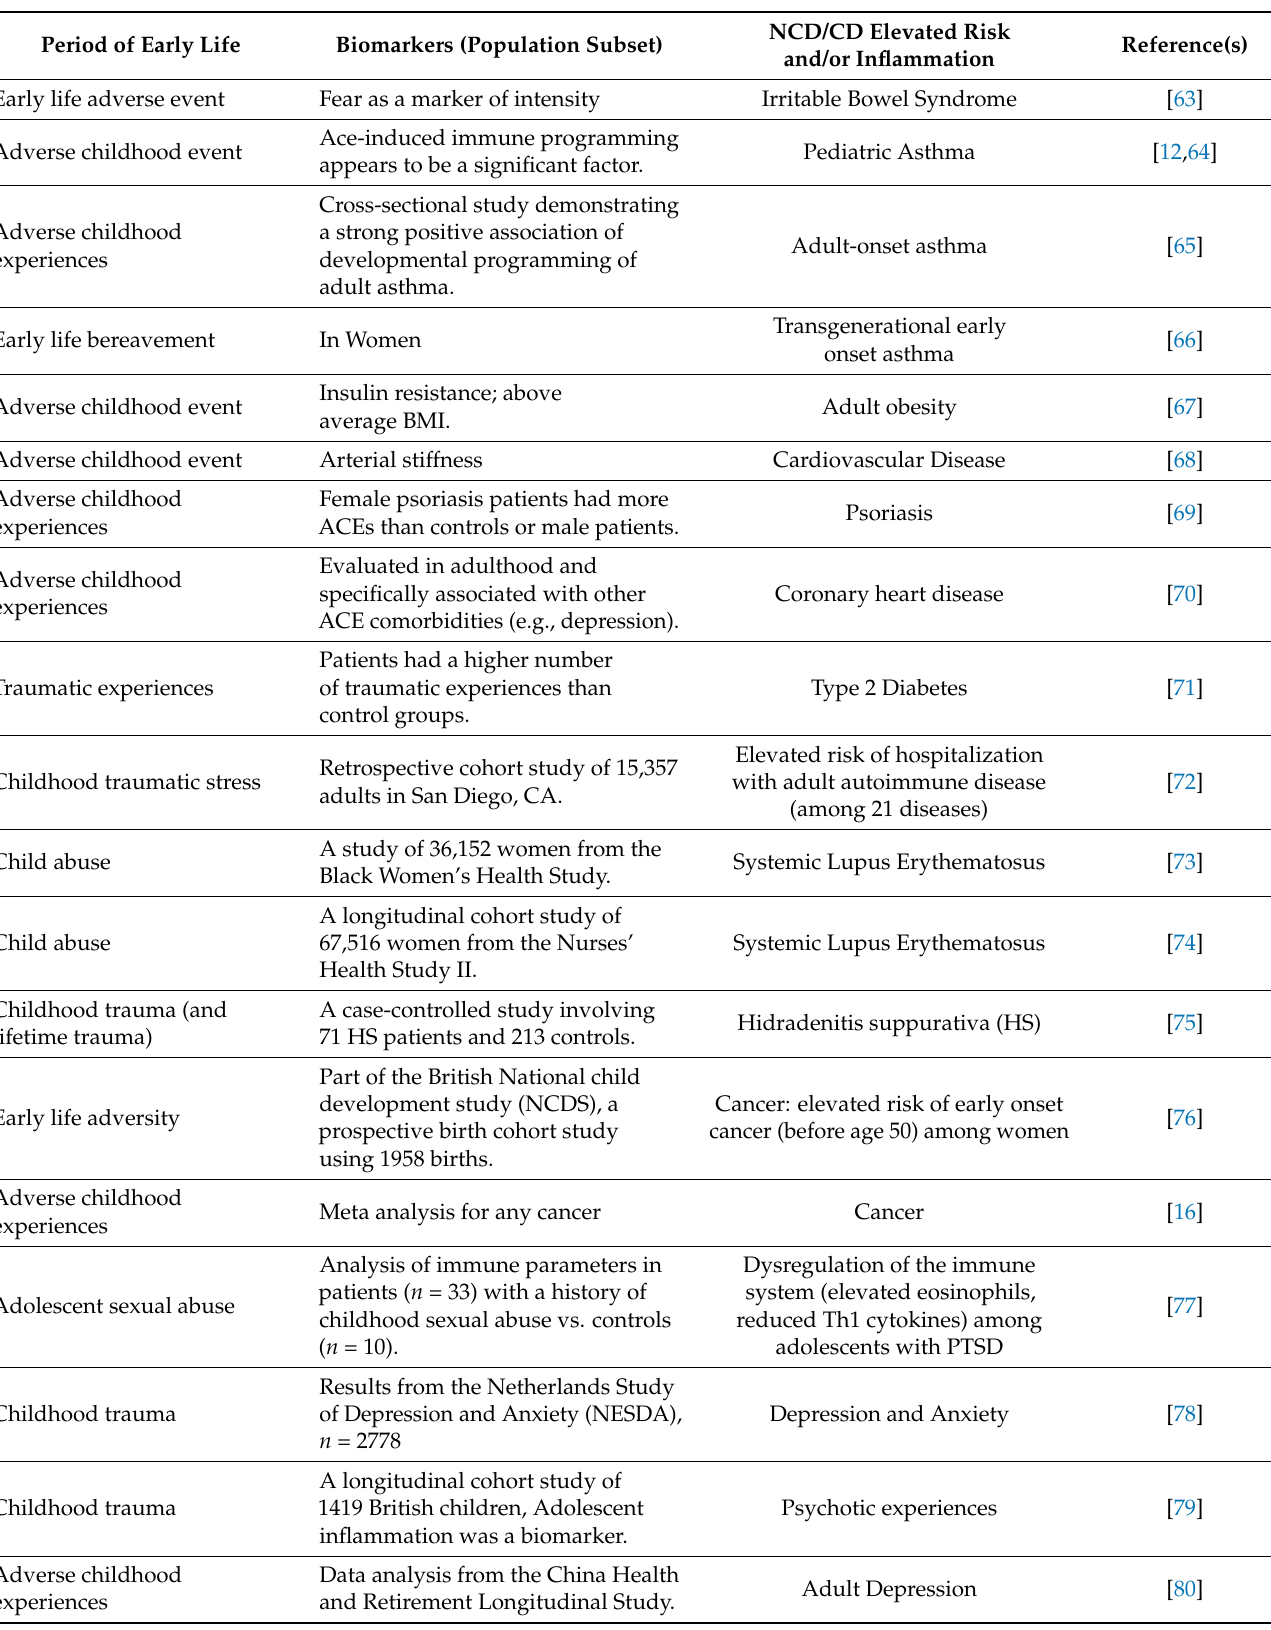
Table 2. Examples of Ealy Life Adverse Events, Inflammation, and Specific NCDs/Chronic Disorders